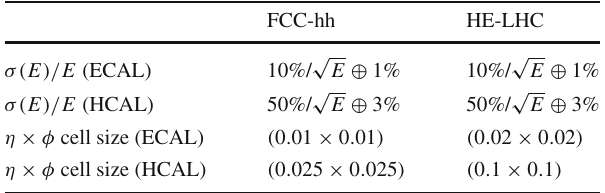
Table2 CalorimeterparametersfortheFCC-hhandHE-LHCdetectors in